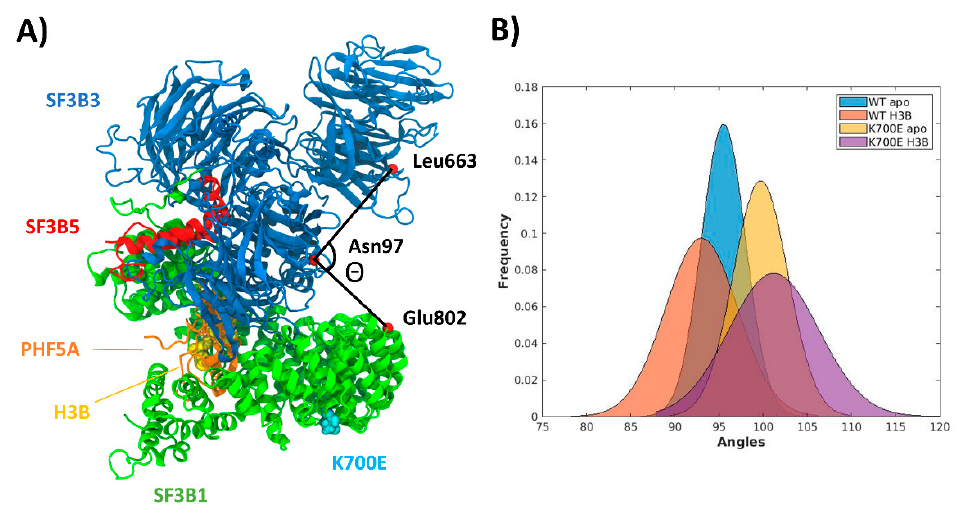
Figure 3. ( A ) Bending angle ( Θ ), defined by the C α atoms of Leu663 and Asn97 in SF3B3 and Glu802 in SF3B1. SF3B1 (green), SF3B3 (blue), SF3B5 (red), and PHF5A (orange) are shown as cartoons while the K700E mutation site is shown as cyan van der Waals spheres. ( B ) Distribution of Θ angle (deg) values sampled during molecular dynamics simulations trajectories for the wild type apo SF3b ( WT SF3b apo, light blue), for WT SF3b in complex with H3B ( WT SF3b H3B , orange), apo SF3b containing K700E SF3B1 ( K700E SF3b apo , yellow) and SF3b containing K700E SF3B in complex with H3B ( K700E SF3b H3B , purple).